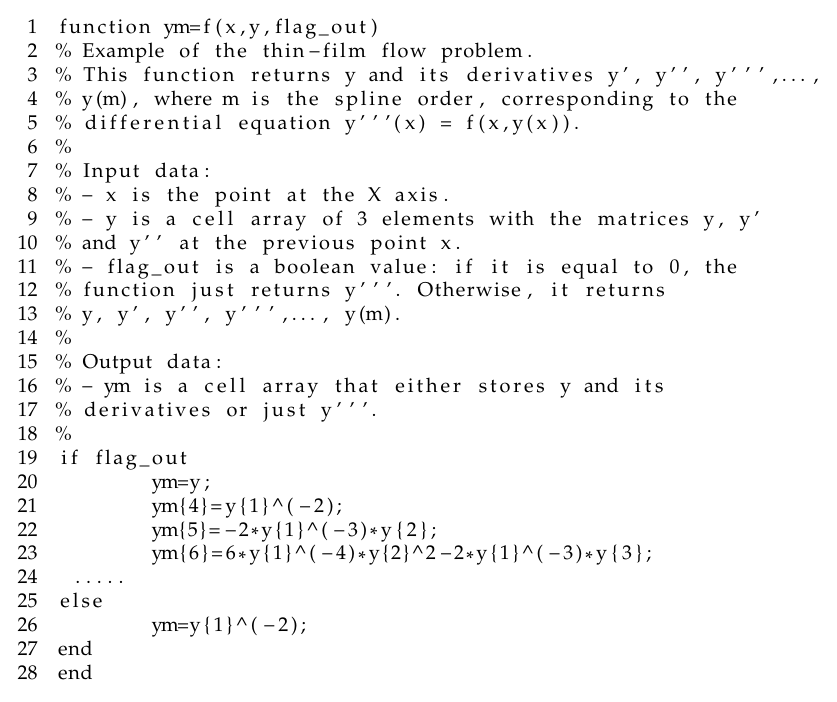
Figure 2. Function f for the thin-film flow of Problem (33).